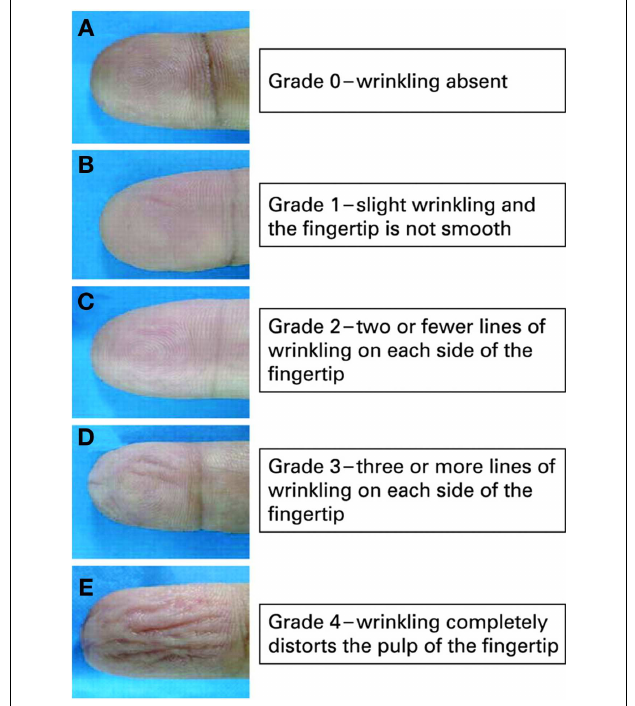
FIGURE 1 |Wrinkling scale.